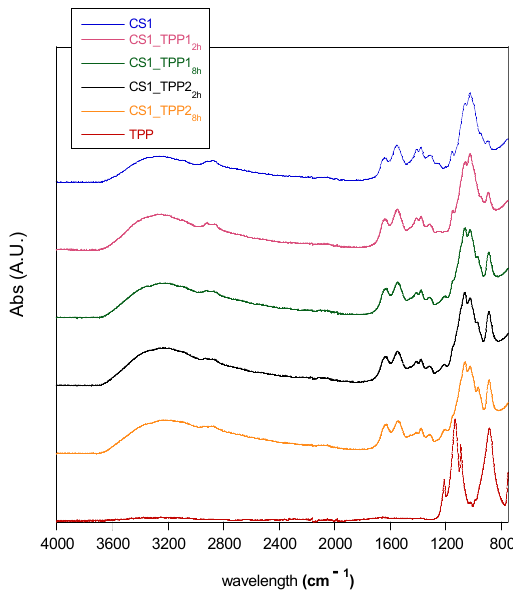
Figure 3. FTIR spectra of TPP, pristine chitosan (CS1), and crosslinked chitosan scaffolds (CS1_TPPY z ).